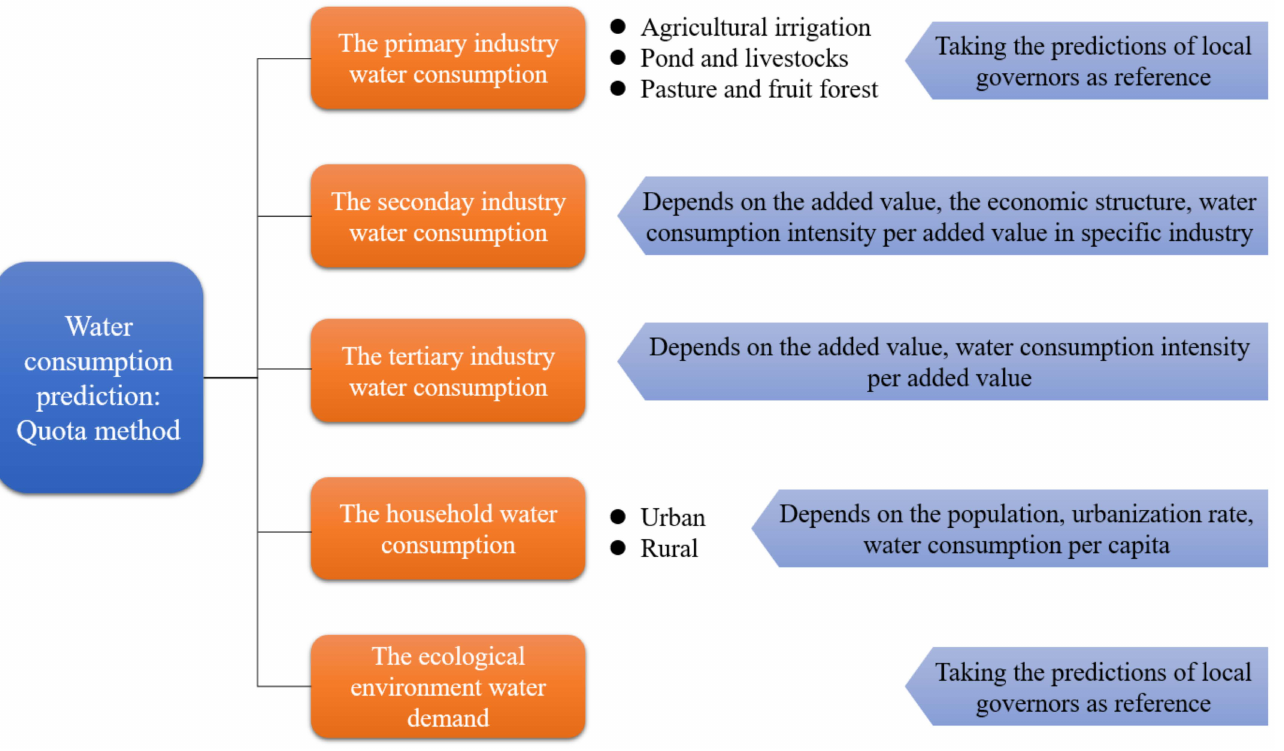
Figure 1. The prediction of water